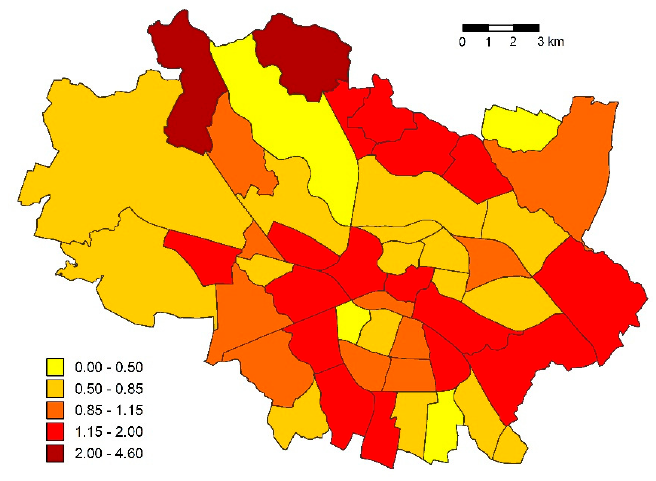
Figure 7. Concentration of medium-high-technology industrial entities in the housing estate of Wrocław in 2016 (sourced by authors).